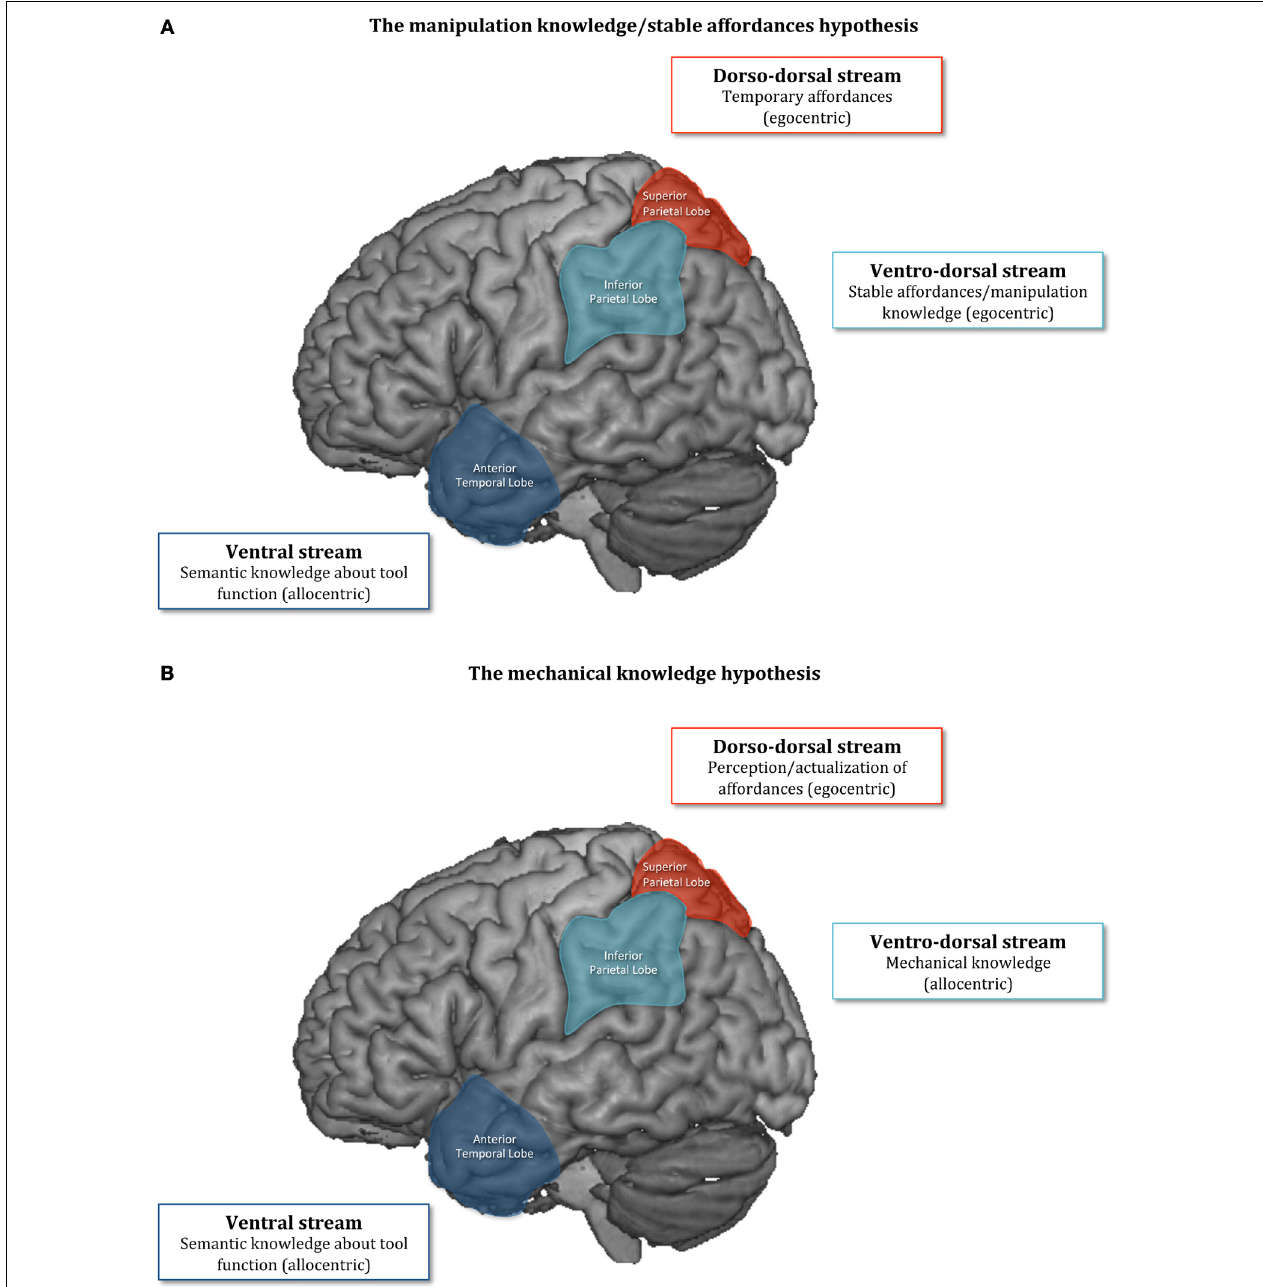
FIGURE 1 | The manipulation knowledge/stable affordances hypothesis (A) and the mechanical knowledge hypothesis (B).